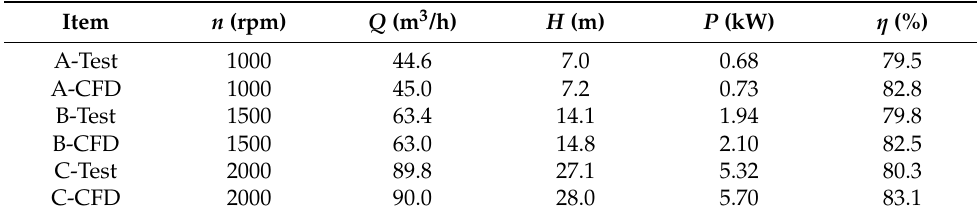
Table 3. BEPs experimental validation of performance